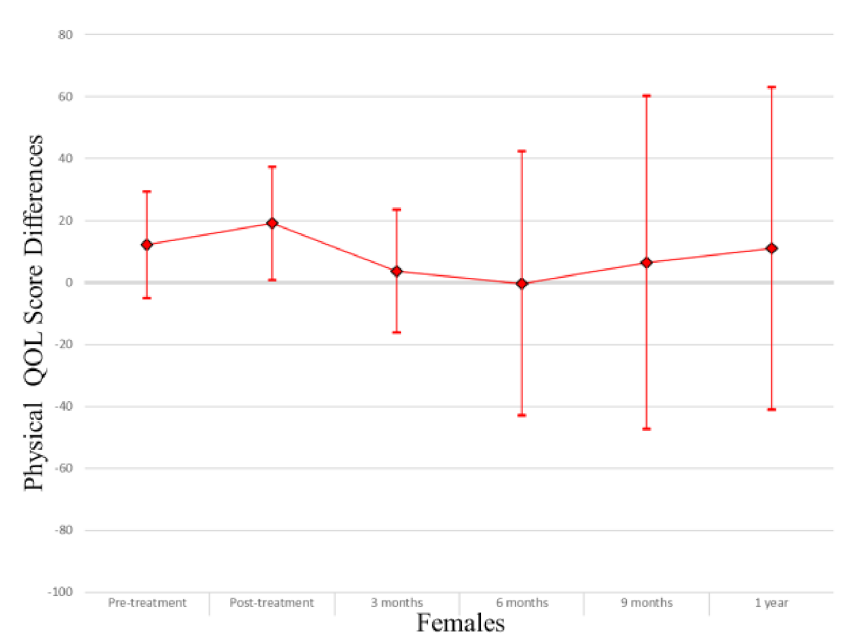
Figure 6. Physical QOL score differences in female study